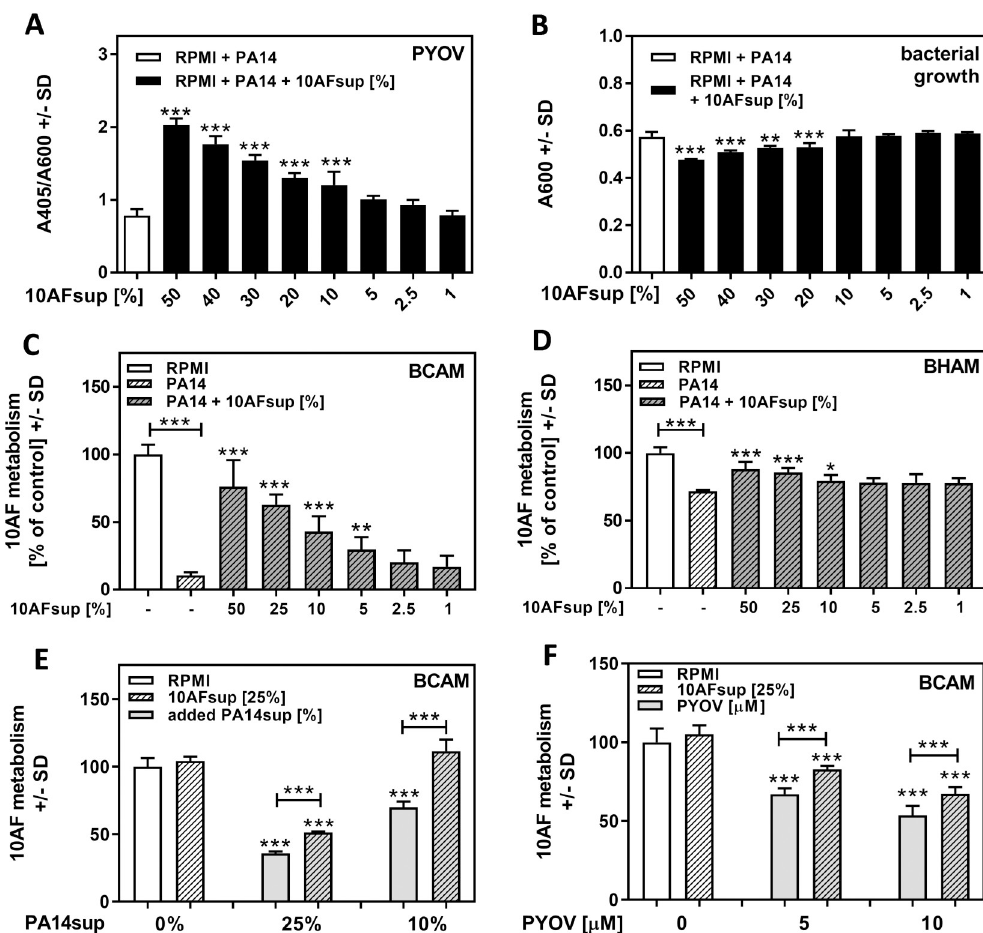
Fig 1. A . fumigatus supernatant effects on P . aeruginosa growth and pyoverdine production . Planktonic 10AF supernatant (10AFsup) was diluted in RPMI from 50% to 0% 10AFsup, and incubated with P . aeruginosa cells (5x10 7 /ml) at 37˚C for 24h. Relative pyoverdine (PYOV) concentrations (A) were calculated using the quotient A405 (PYOV)/A600 (bacterial growth: B). Supernatants shown in A and B, as well as PA14 supernatant not containing 10Afsup, were compared with respect to their activities on 10AF forming biofilm (C: BCAM) or preformed biofilm (D: BHAM) metabolism. E: 10AF forming biofilm was incubated with 10 or 25% PA14 wildtype supernatant with or without the addition of 25% 10AFsup for 24 hours. Effects on 10AF forming biofilm metabolism were evaluated by XTT assay. F: 10AF forming biofilm was incubated with 5 or 10 μ M pyoverdine (PYOV) with or without the addition of 25% 10AFsup for 24 hours. Effects on 10AF forming biofilm metabolism were evaluated by XTT assay. Statistics for A and B: 1way ANOVA, RPMI (white bar) vs. all groups containing Afsup (black bars). Statistics for C and D: 1way ANOVA, PA14 supernatant (white striped bar) vs. PA14 supernatant containing 10AFsup (grey striped bars). Other comparisons by t-Test as indicated by the ends of the brackets. Statistics for E and F: t-Test, RPMI (white bar) vs. all other bars. Other comparisons as indicated by the ends of the brackets. One, two or three asterisks = p � 0.05, p � 0.01 or p � 0.001,